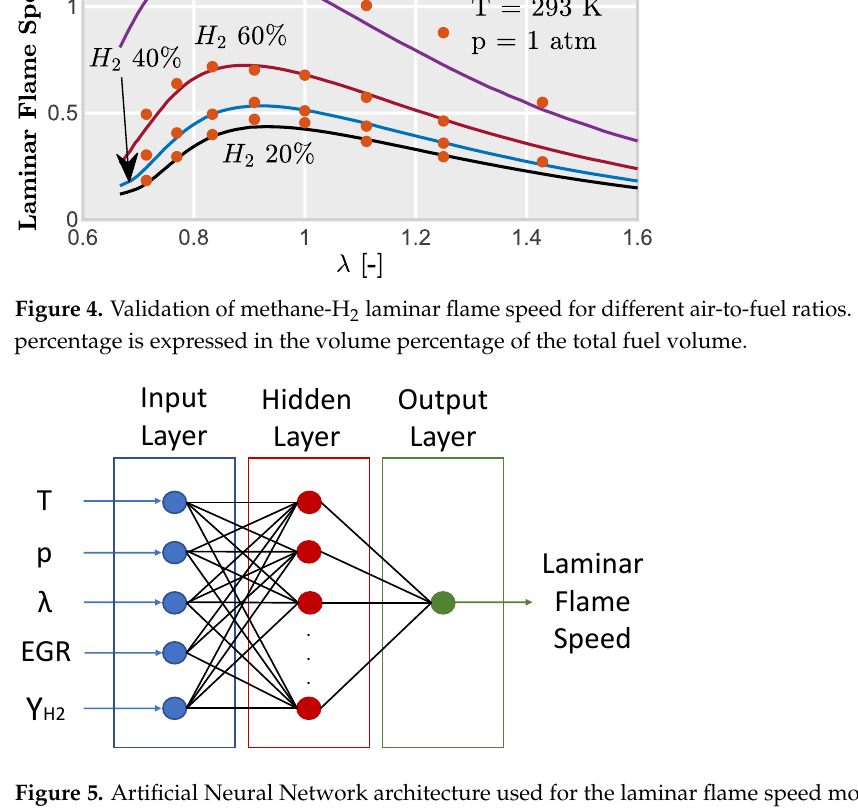
Figure 5. Artificial Neural Network architecture used for the laminar flame speed modelling. This ANN calculates the outputs ( y ) using the equation Equation (7).